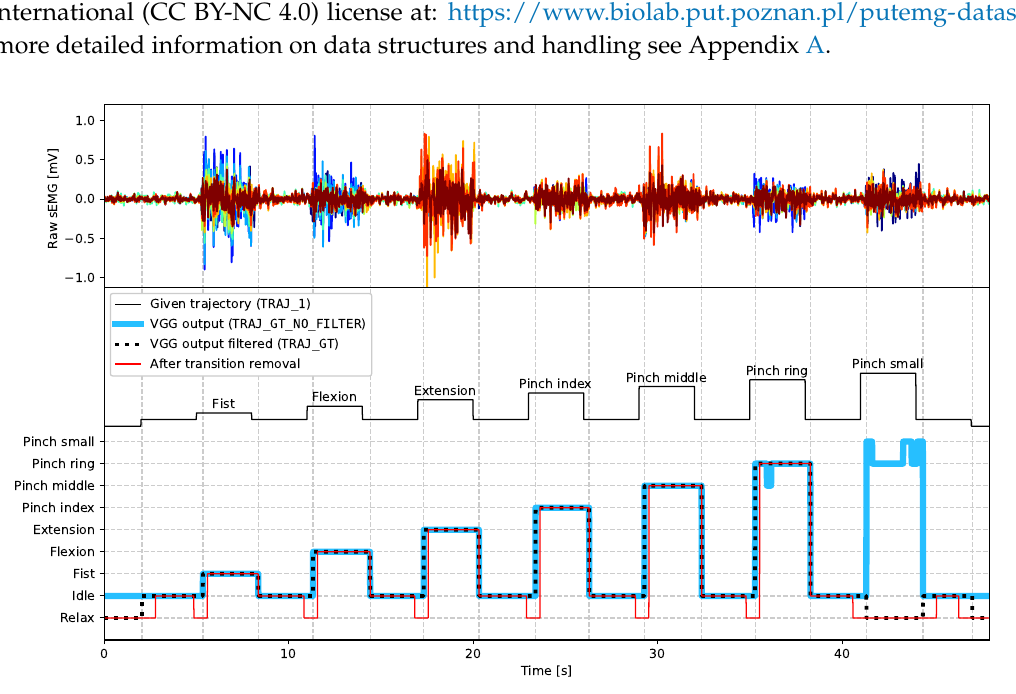
Figure 4. Exemplary fragment of ground-truth label processing stages; fist — pinch middle : gestures were performed and recognised properly, only transition points were adjusted; pinch ring : the gesture was mostly recognised as correct, mistakes in VGG output were filtered; pinch small : the gesture was mostly recognised as incorrect, the whole gesture was rejected; vertical grid corresponds to transitions in VGG output